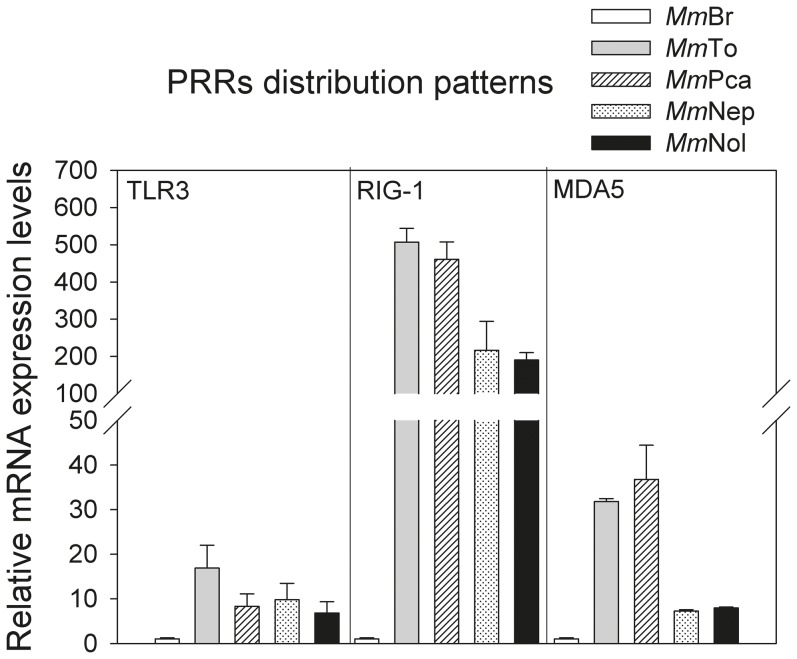
PRRs distribution patterns in the established unstimulated M. myotis cell lines.The mRNA expression levels of TLR3, RIG-1 and MDA5 in MmBr, MmTo, MmPca, MmNep and MmNol were determined by qRT-PCR (n = 3). The expression level was shown as a related fold and normalized against β-actin. The expression level of different genes in MmBr showed the lowest expression and was presented as one fold.